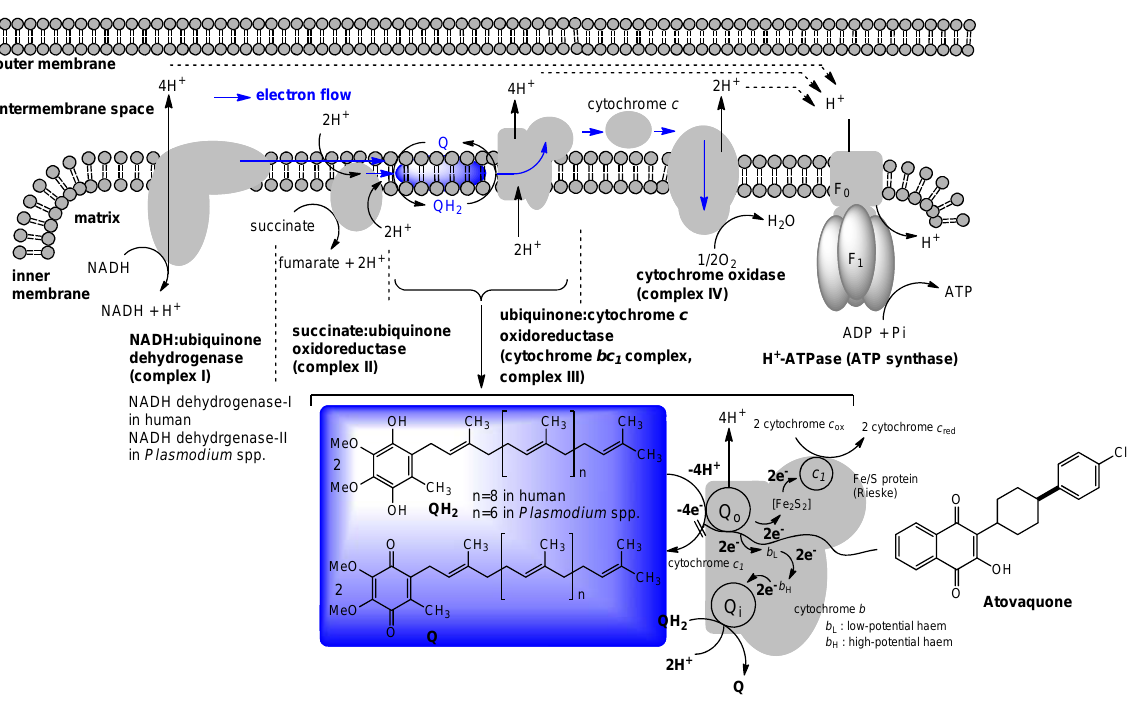
Figure 5. Schematic representation of mitochondrial electron transport chain and the proposed binding site of atovaquone.